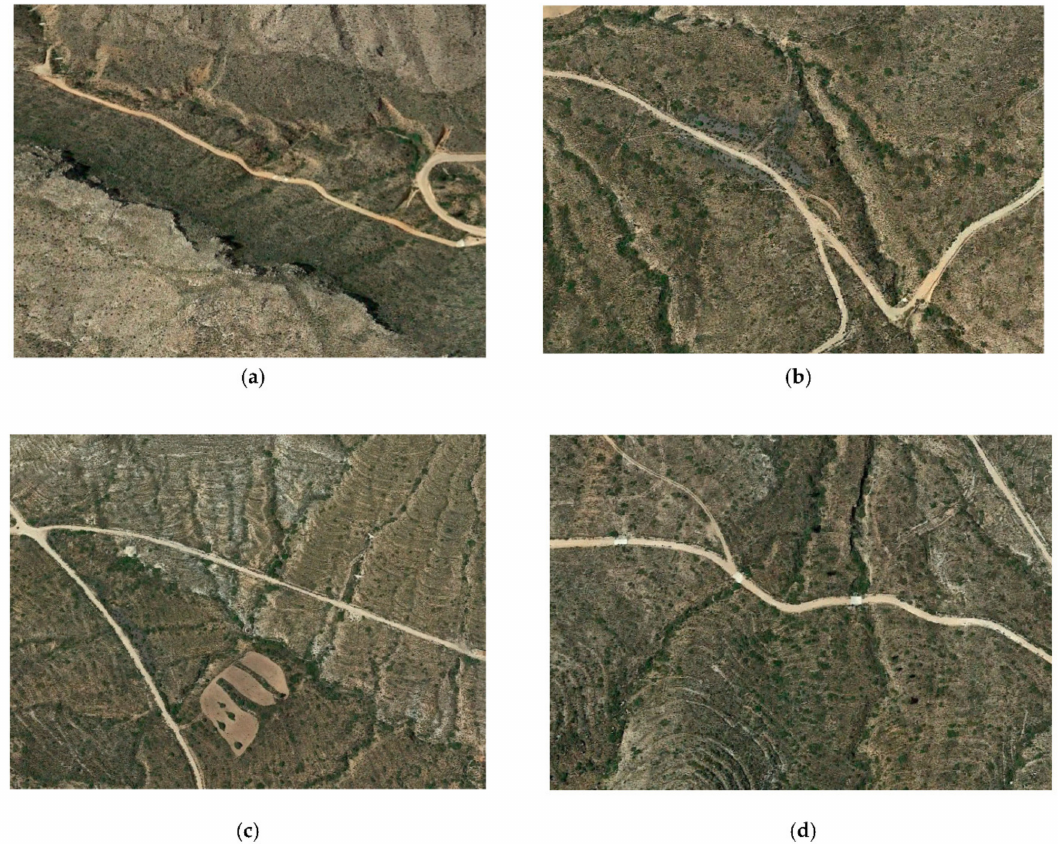
Figure 2. Aerial views of roads (unpaved roads in burned, ( a ), and unburned, ( b ), areas; rock-paved roads in burned, ( c ), and unburned, ( d ), areas) in Hell í n (Central-East